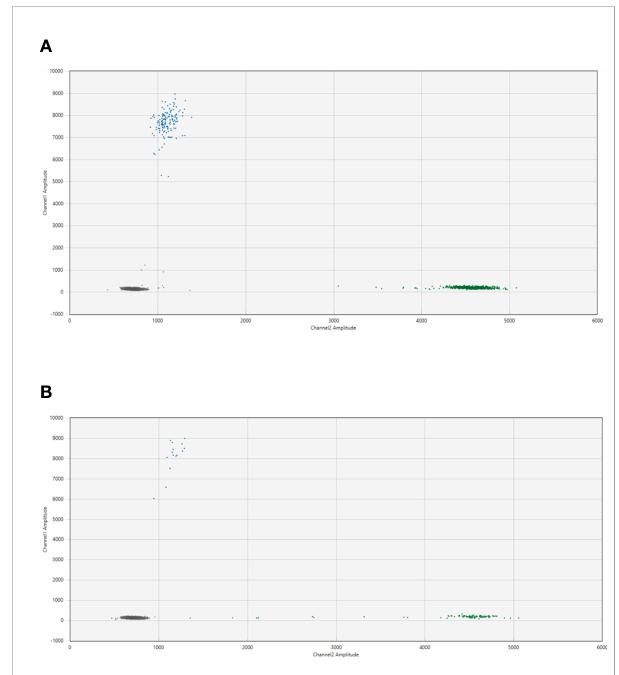
FIGURE 2 2D plot from the ddPCR assay for NB2049 with (A) . cfDNA from the diagnostic plasma sample (total cfDNA input 25.6 ng/well) and (B) . positive control with DNA from FFPE material from the primary tumor (total cfDNA input 3.3 ng/well). Blue dots; droplets positive for patient-speci fi c breakpoint (FAM channel) Green dots; droplets positive for ACTB (HEX channel) Grey dots; droplets negative for both targets.